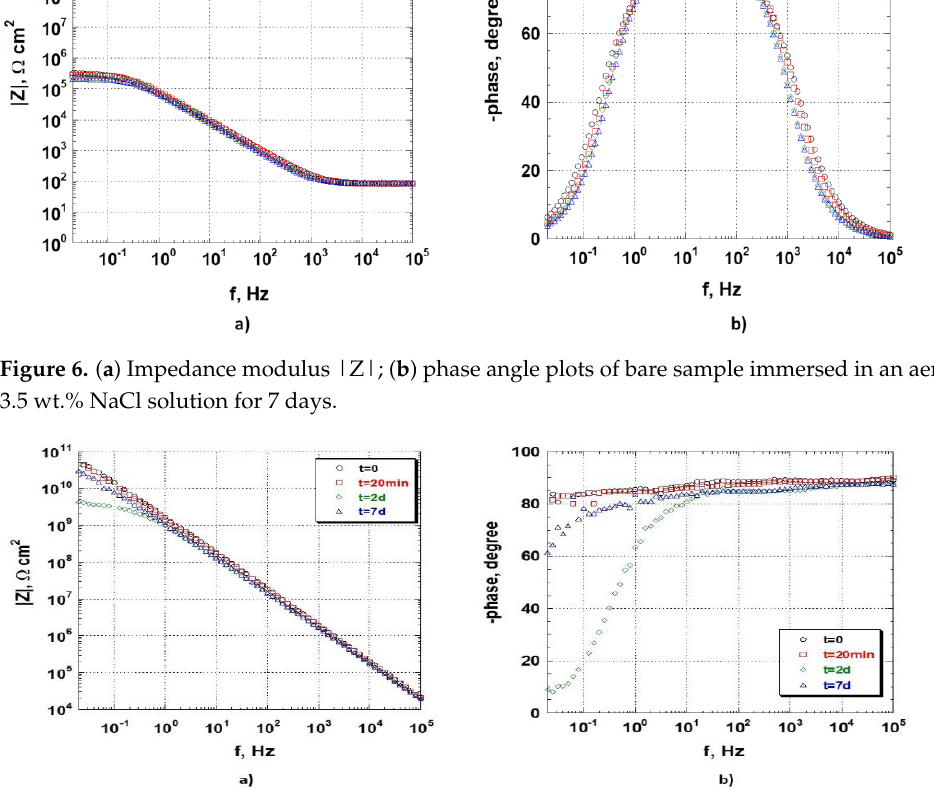
Figure 7. ( a ) Impedance modulus |Z|; ( b ) phase angle plots of CCrR sample immersed in an aerated 3.5 wt.% NaCl solution for 7 days.